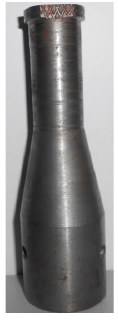
Figure 5. Sonotrode.